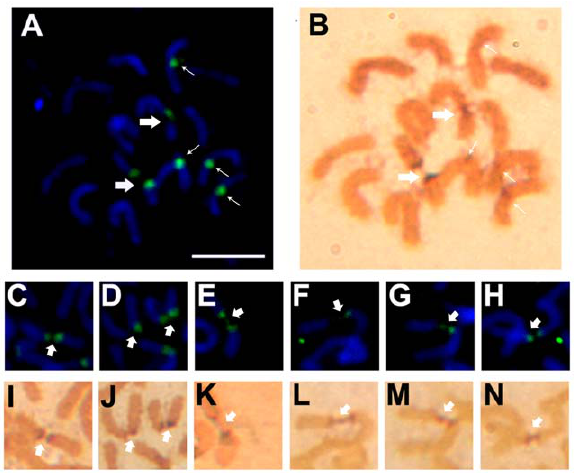
Figure 2. Co-localization of Ag-NOR proteins and 45S rDNA lesions in untreated ryegrass metaphase chromosomes. (A) FISH mapping showed two 45S rDNA lesions (thick arrow) and four intact 45S rDNA sites (thin arrow). (B) Intense staining of Ag-NOR proteins co- localized at the same lesion site shown in figure A (thick arrow). In contrast, there was no signal or only very weak signals detected at intact 45S rDNA sites (thin arrow). (C–H) Examples of different cytological appearances of 45S rDNA lesions (thick arrow). (I–N) A one-to-one comparison was made between silver-staining signals and 45S rDNA lesions shown in figure C–H (thick arrow). Bar=10 m m.